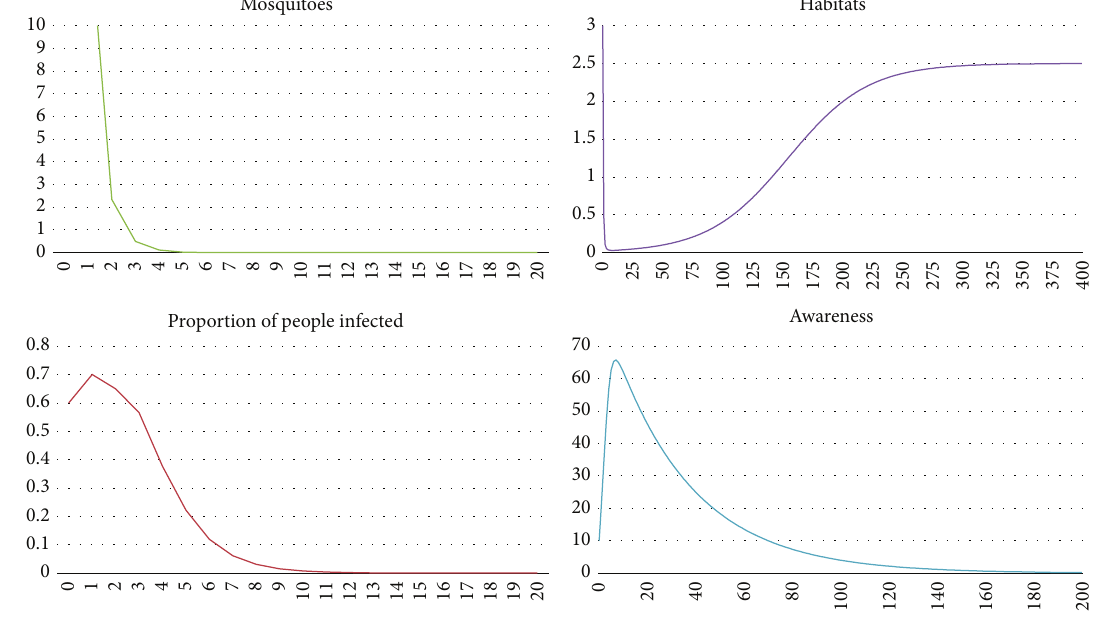
Figure 2: The above graph is generated with parameter values 𝑎 = 0.5 , 𝑝 = 0.5 , 𝑏 = 5 , 𝑐 = 0.6 , 𝑙 = 0.5 , 𝑖 = 0.5 , 𝑟 = 0.97 , and 𝑓 = 20 (the parameters are placed in the region where 𝑏 > (1 − 𝑐)(1 − 𝑙) ). One can see that the solutions display convergence to the equilibrium for big values of 𝑟